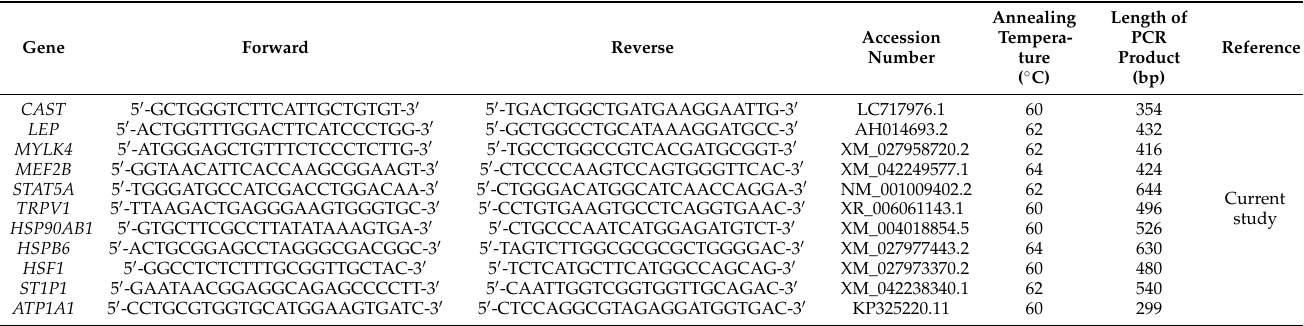
Table 2. Forward and reverse primer sequence, length of PCR product and annealing temperature for growth and heat tolerance genes used in PCR-DNA